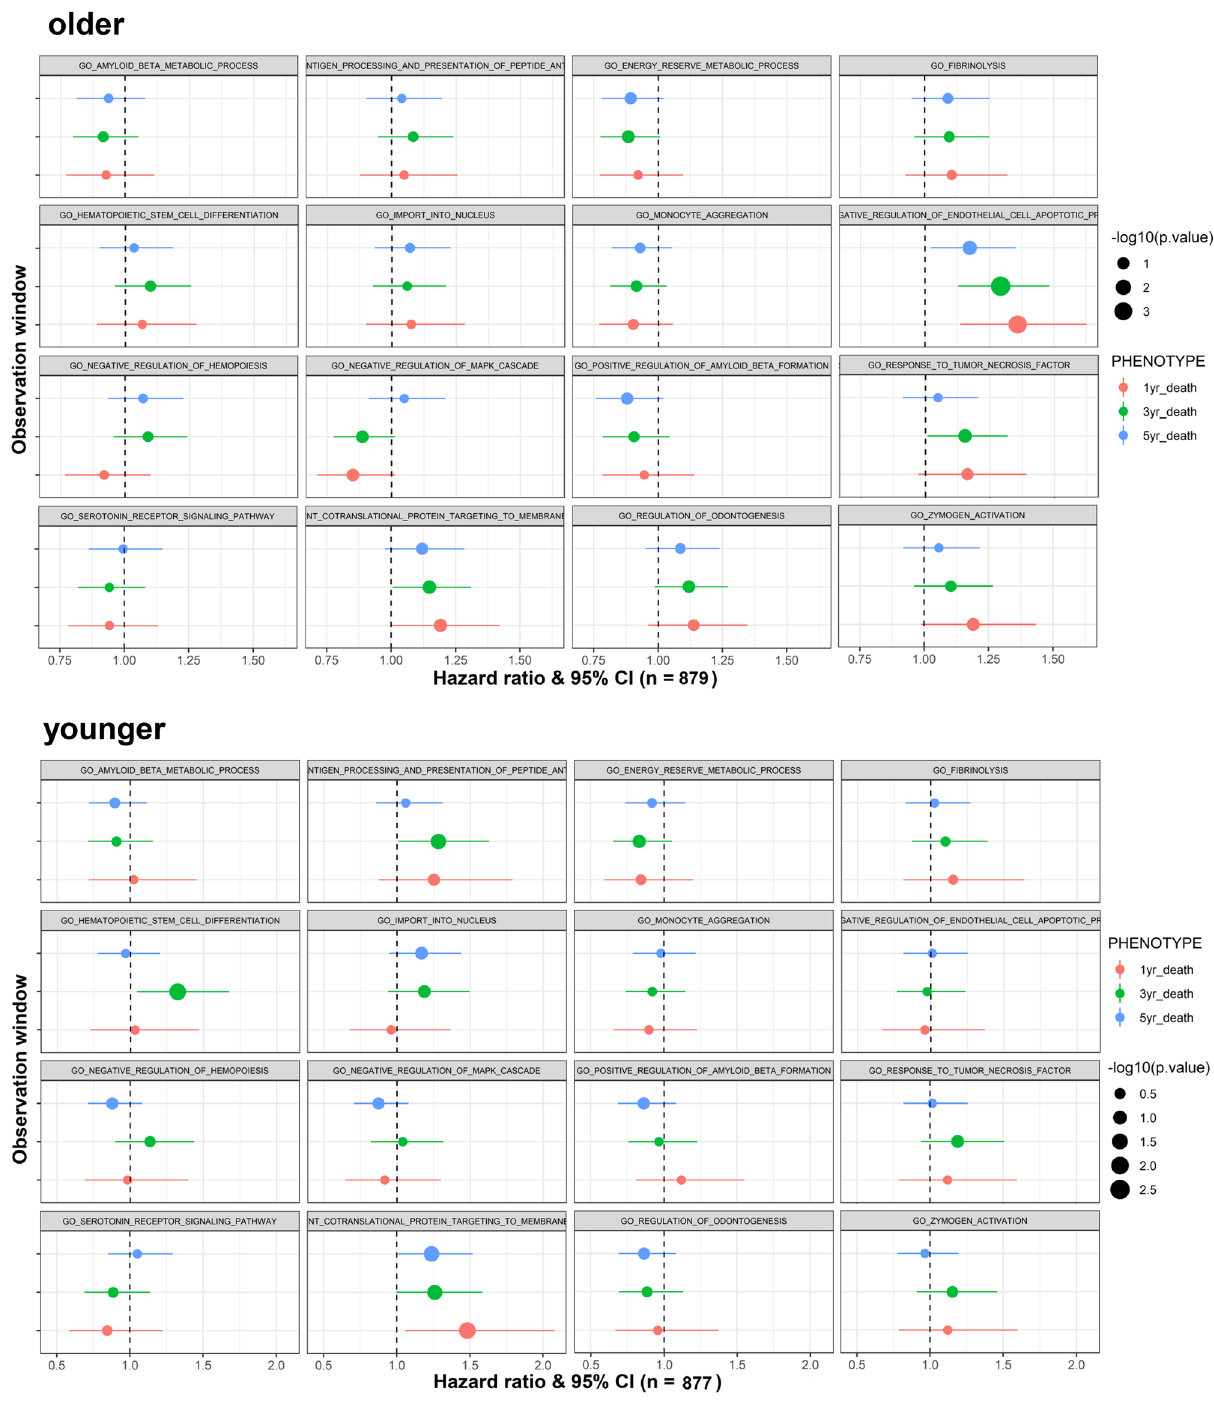
Figure 6. Hazard ratio of each pathway-specific PRS for 1-year, 3-year, and 5-year calendar period of follow-up in all samples as well as subgroups stratified by age at index stroke. The HRs were calculated by the univariate Cox proportional-hazards regression model. The X-bar represents 95%CI of the effect size. Top 16 PRSs were selected from 31 PRS candidates with p-value < 0.1 in association with 3-year mortality from the initial univariate Cox regression model in the training dataset. ( A ) older stroke subgroup; ( B ) younger stroke